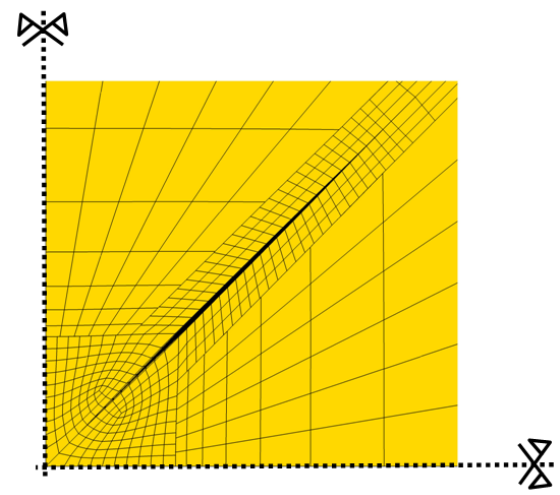
Figure 4: Simulation result of Vickers indentation on a ZrO 2